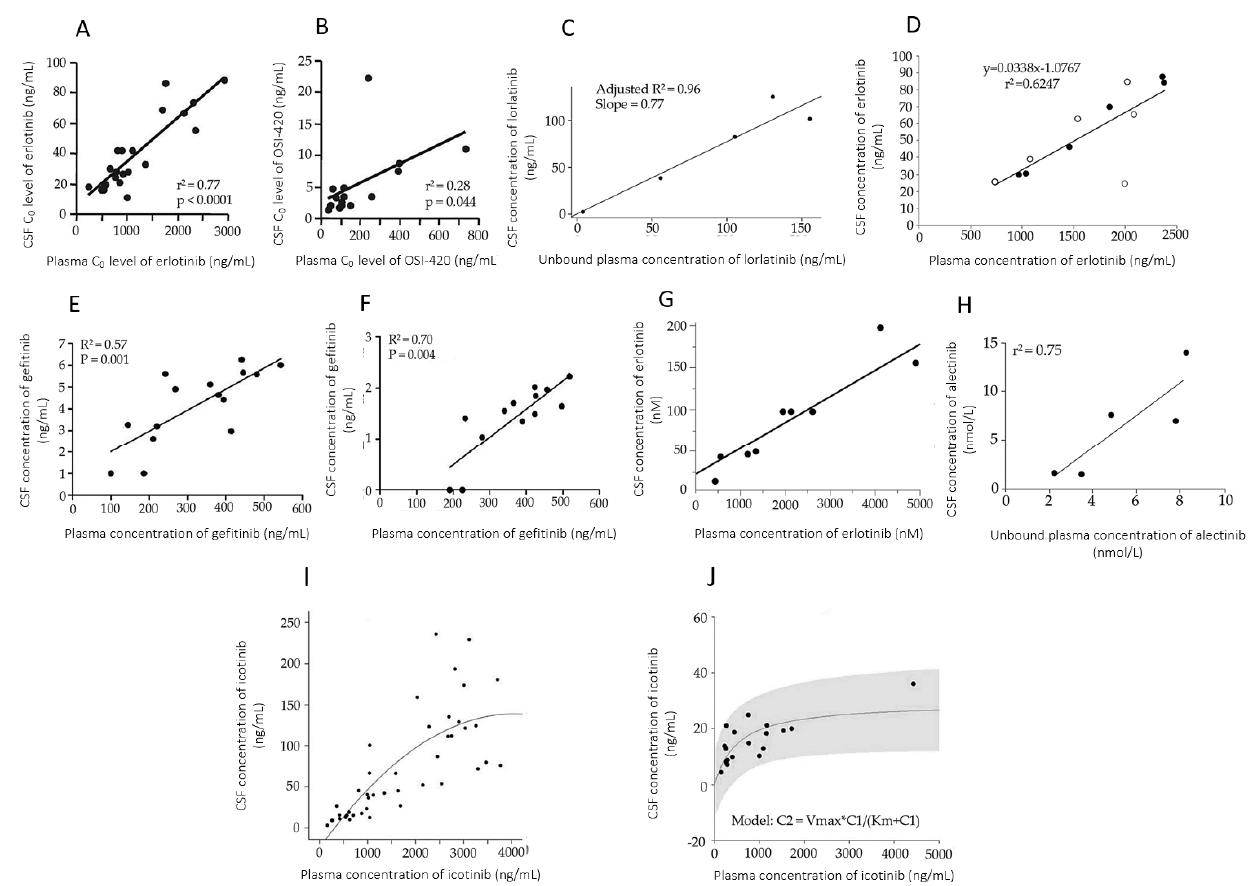
Figure 3. Relationships of the concentrations of various orally administered, small-molecule anticancer drugs with specific cellular protein targets in serum/plasma and in cerebrospinal fluid (CSF). ( A ) Erlotinib in plasma and in CSF, trough samples were drawn. ( B ) O-desmethyl-erlotinib (OSI-420) in plasma and in CSF, trough samples were drawn. ( C ) Unbound alectinib in plasma and in CSF. ( D ) and ( E ) Gefitinib in plasma and in CSF. ( F ) Unbound lorlatinib in plasma and in CSF. ( G ) and ( H ) Erlotinib in plasma and in CSF. ( I ) Gefitinib in plasma and in CSF, a Michaelis–Menten equation has been fitted to the data. ( J ) Icotinib in plasma and in CSF [50,61–64,70,77,83]. Licenses or permissions to reproduce the graphs have been granted by the copyright holders.